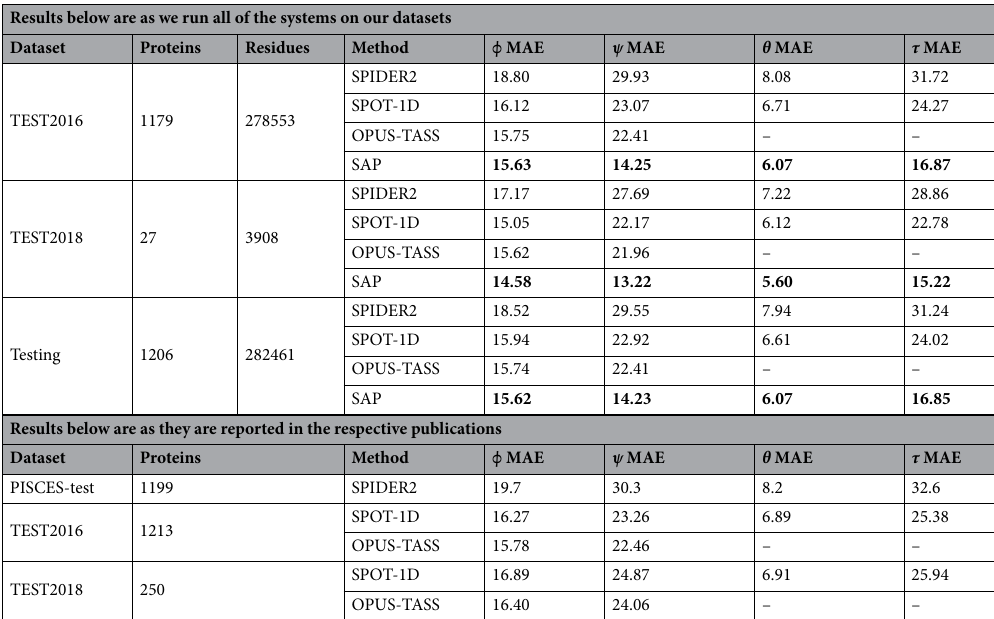
Table 5. Performances of SPIDER2, SPOT-1D, SAP, and OPUS-TASS on our testing dataset and its subsets TEST2016 and TEST2018. The emboldened values are the wining numbers for the corresponding types of angles and datasets. OPUS-TASS does not predict θ and τ angles while the other three methods predict all four types of angles.